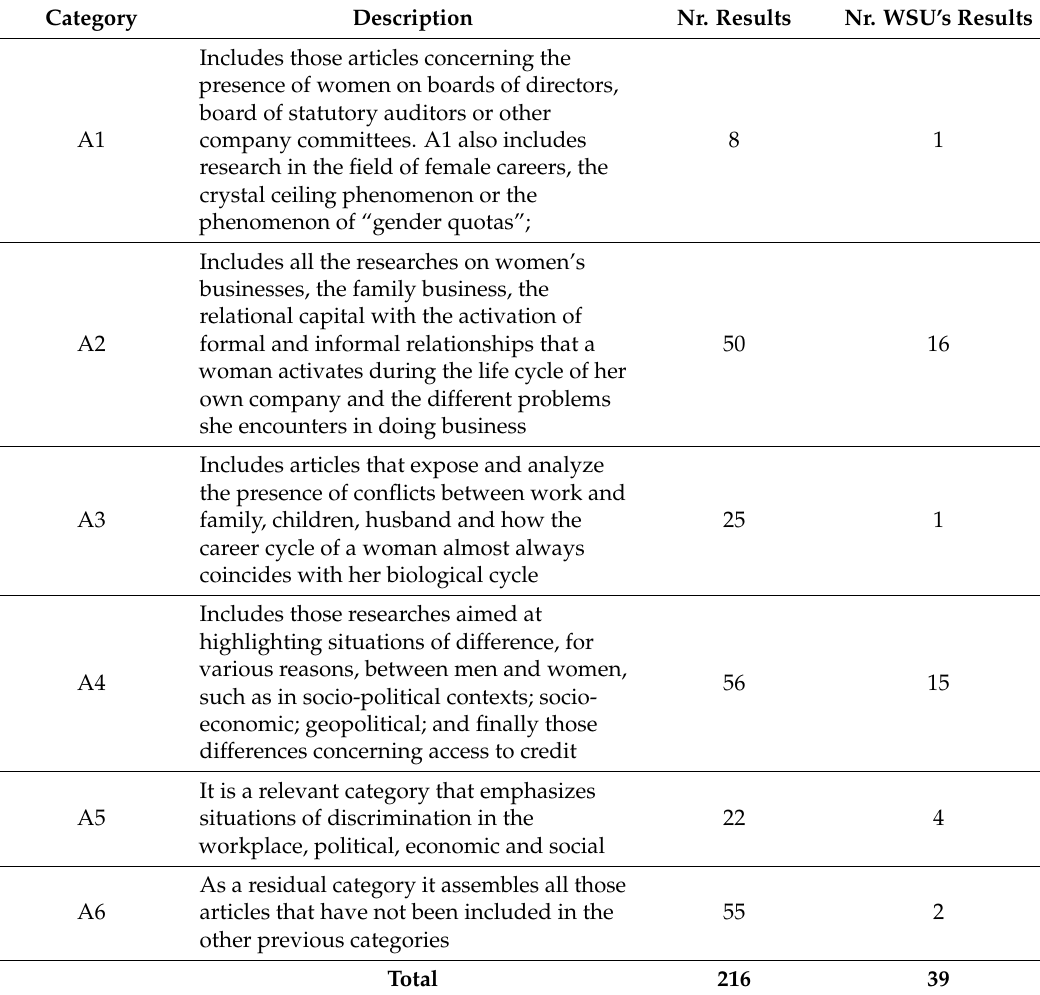
Table 1. Summary of